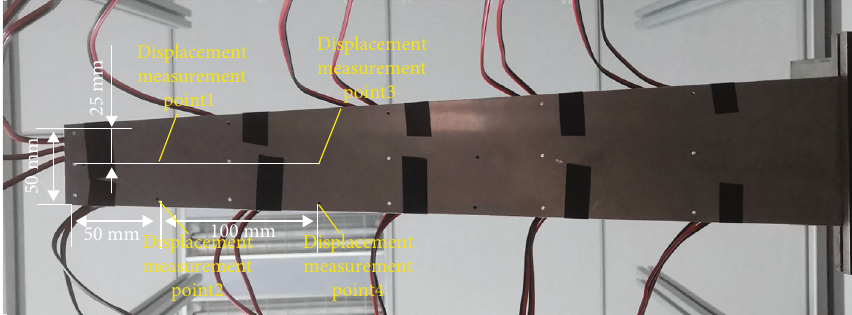
Figure 4: Layout of displacement measuring points.